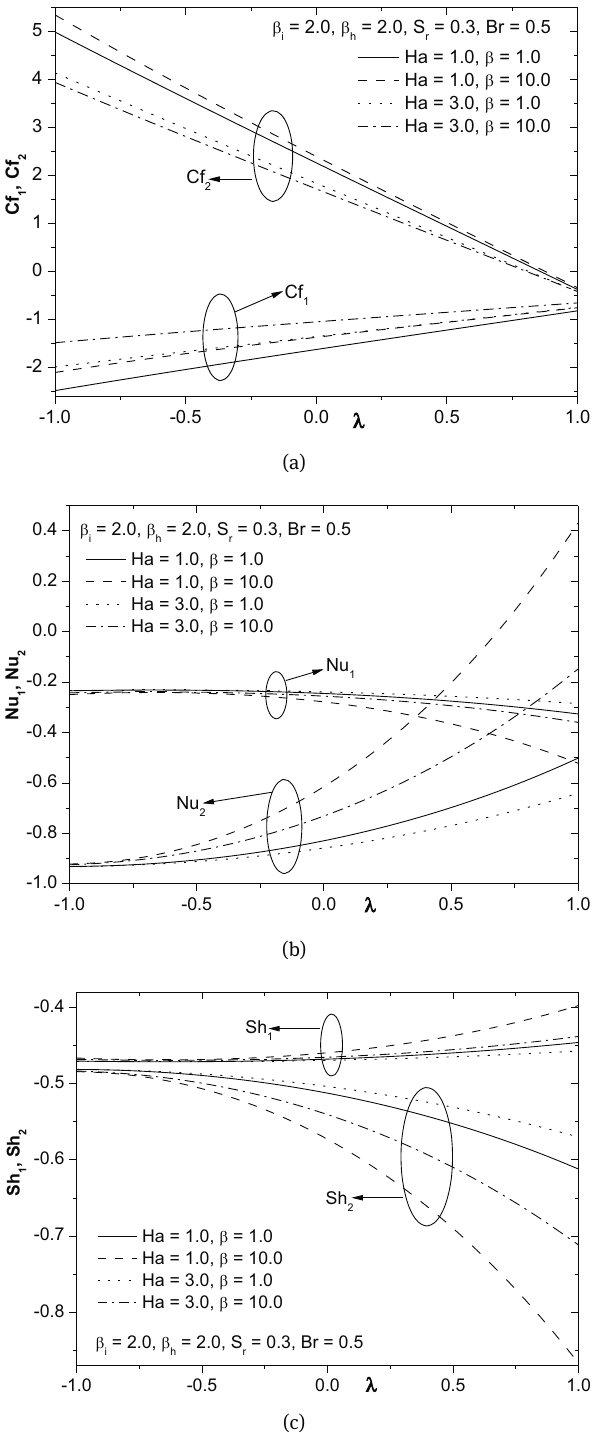
Fig. 4: Effect of Ha and β on (a)skin friction, (b)heat transfer rate, (c)mass transfer rate profiles at both the walls of the